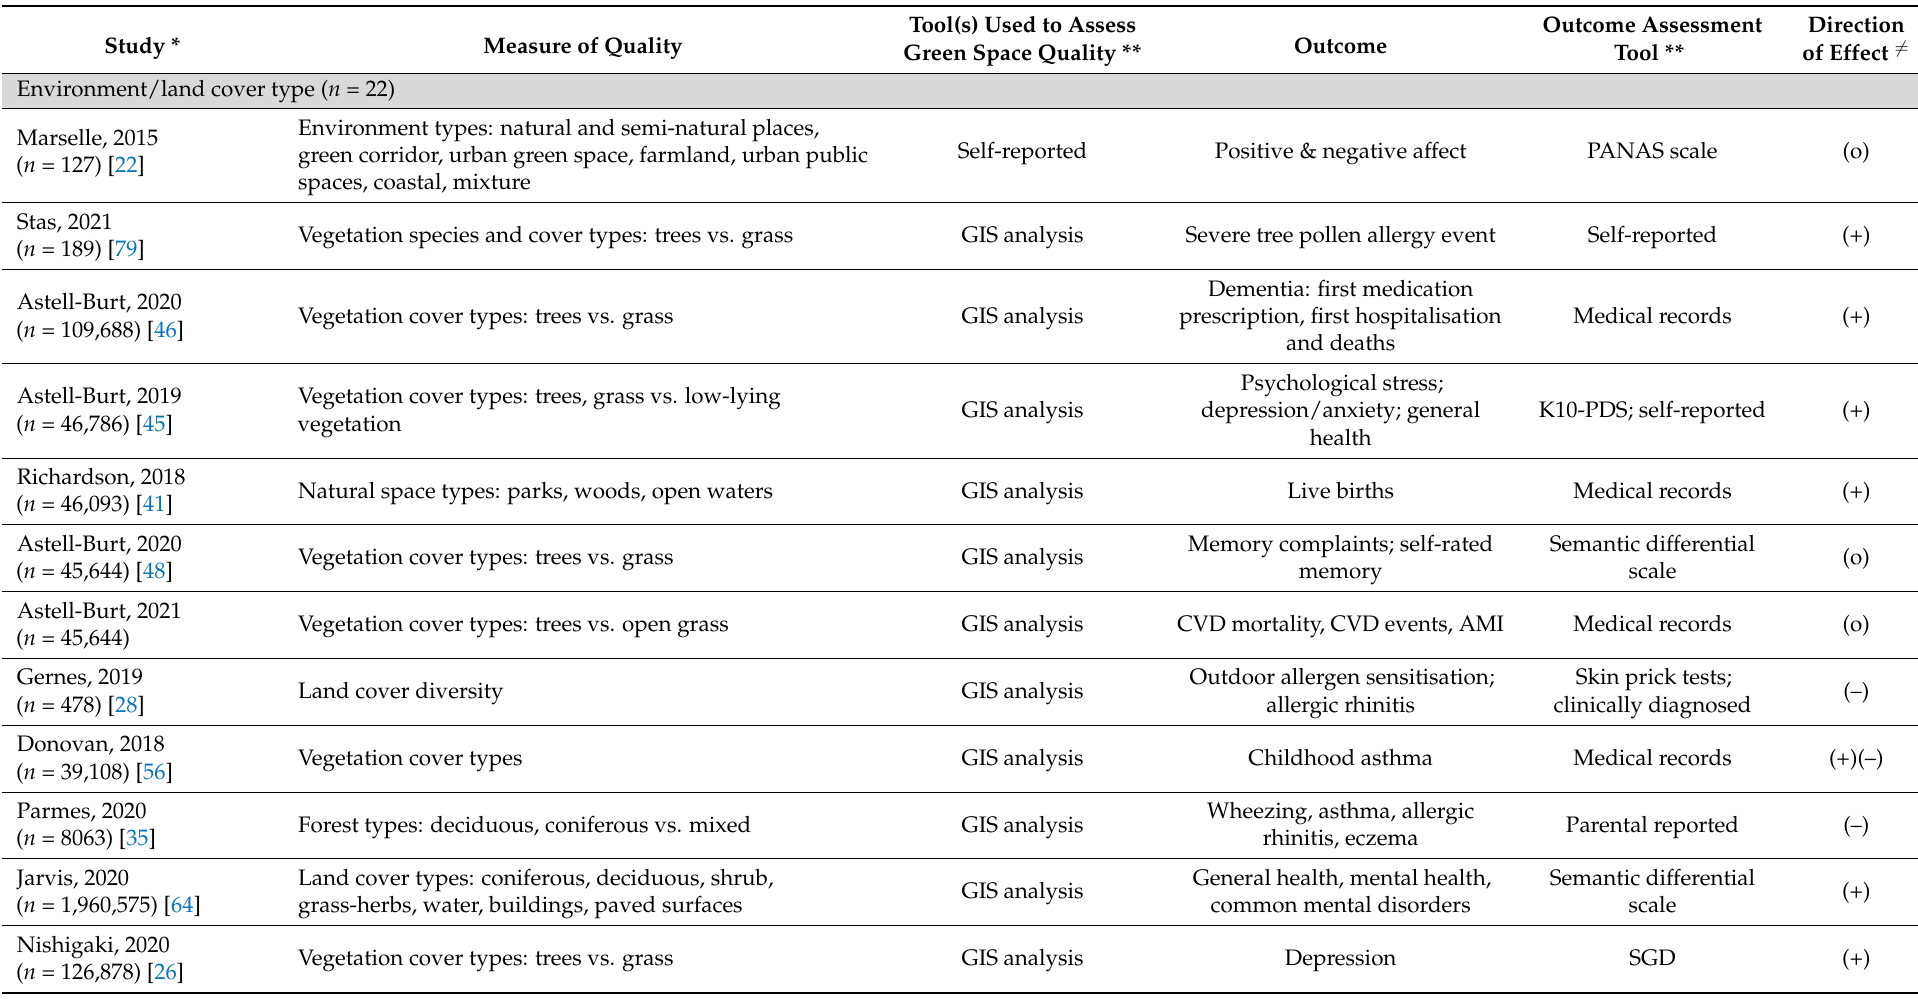
Table 3. Summary of